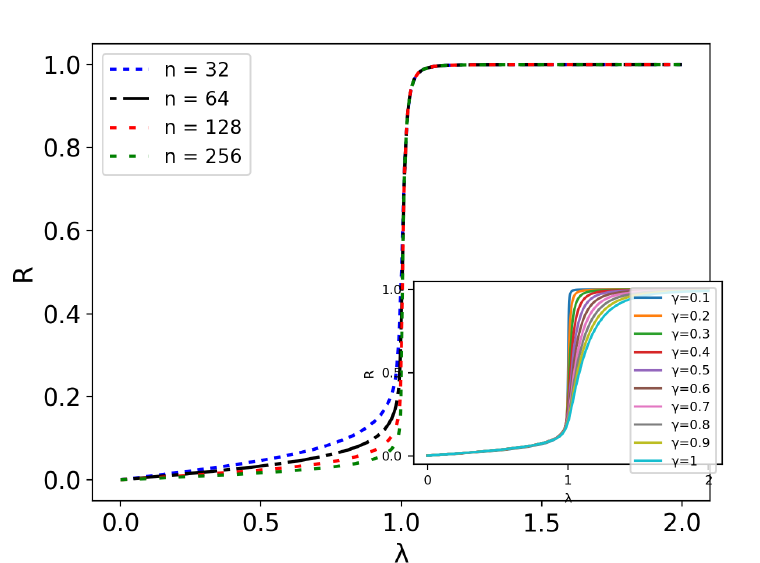
Figure 6: The compatibility index R ( n , λ ) for the X Y Ising chain at different values of n , up to n = 256, with γ = 0.2 as a function of λ . Inset: the compatibility index R ( γ , λ ) for the X Y Ising chain, for different values of γ ∈ ( 0,1 ] and n = 64, as a function of λ . The behaviour of R in the parametric regions appears to sharpen as γ gets closer to 0. This effect can be seen in the inset of Fig. 6, that displays the different behaviour of R as γ varies in ( 0,1 ] , with n